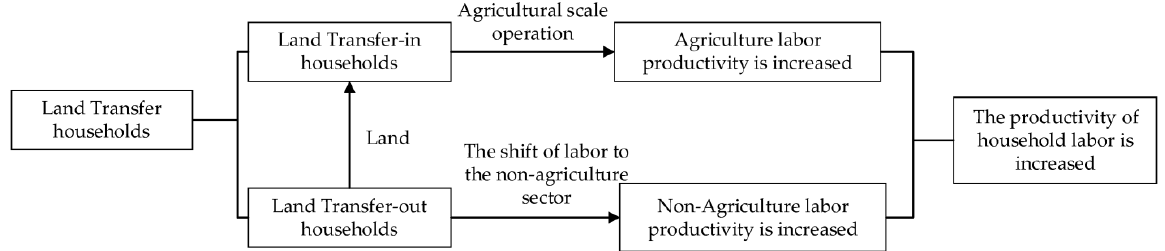
Figure 2. Theoretical analysis framework.